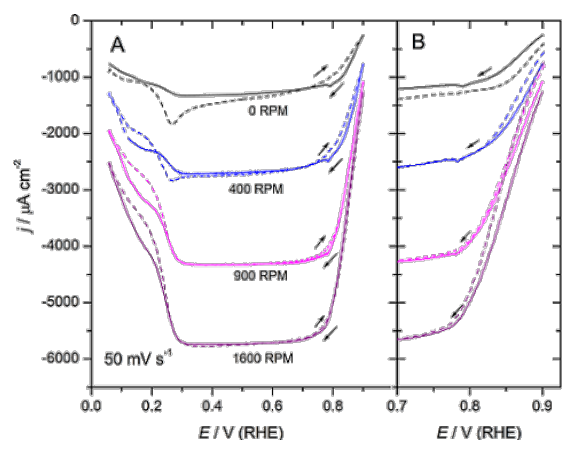
Figure 3: Oxygen reduction on a Pt(111) electrode in oxygen satu- rated 0.1 M HClO 4 . (A): Cyclic voltammetric profile: Positively (dashed line) and negatively directed (solid line) sweeps. The electrode was kept at the initial potential E i = 0.06 V for 10 s before each measure- ment. (B): Negatively directed sweeps when the electrode was kept at E i = 0.06 V (solid line) and at E i = 0.90 V (dashed line) for 10 s before each measurement